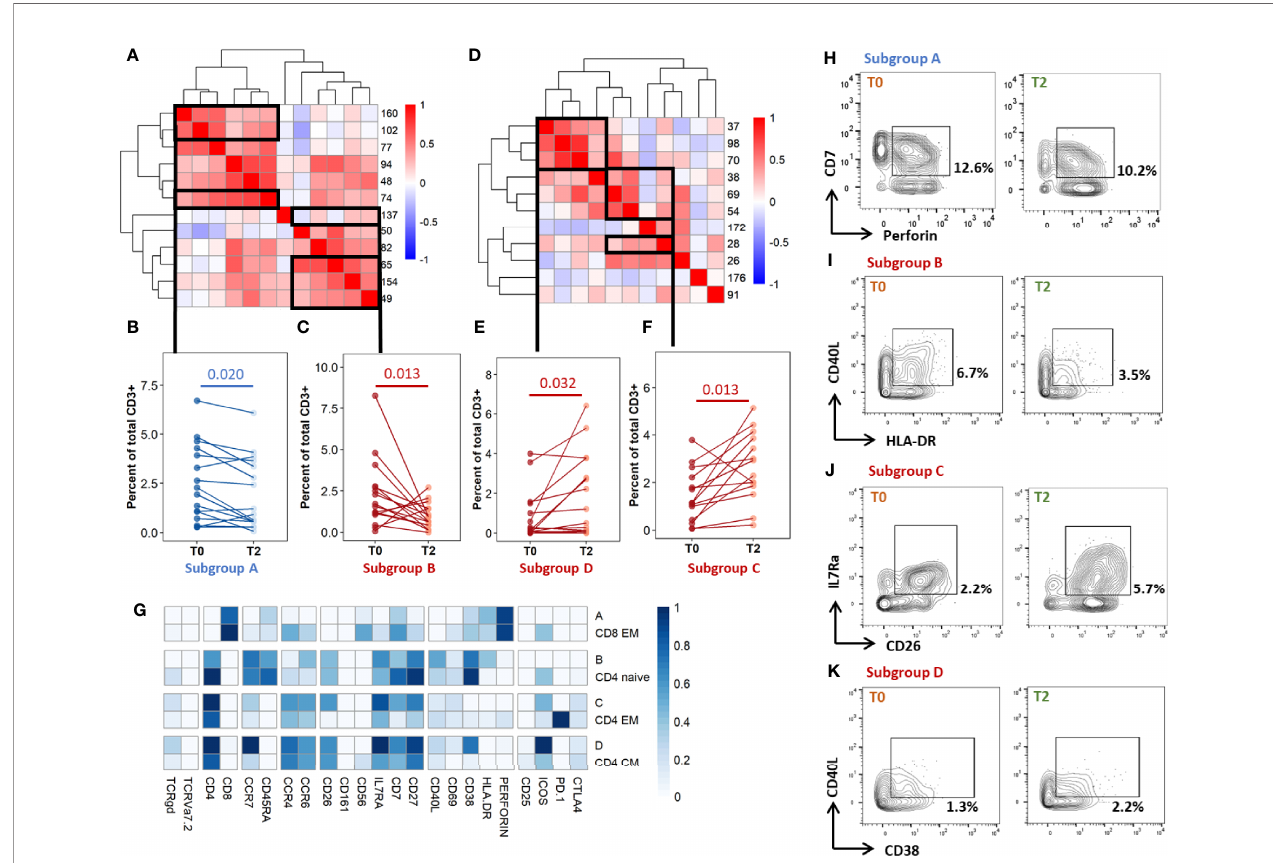
FIGURE 5 | Individual immunopro fi ling con fi rms differential abundance of correlated subsets in cured patients after treatment. Cluster were strati fi ed by type of signi fi cant abundance change: enrichment (A-C) or depletion (D-F) after treatment completion. (A, D) Pearson ’ s correlations were calculated on cluster abundance at T0 and displayed on a heatmap with hierarchical clustering. Clusters with similar immunophenotypes ( Figures 3 , 4 ) and positive correlation coef fi cients were grouped. Estimates of effect sizes are in Supplementary Tables 6, 7 . (B, C, E, F) The abundance of each subgroup was visualized. Each dot represents data for one patient. Statistical analysis: Friedman rank sum test. Subgroup A: data from rmsHBHA samples (n =14), clusters 74, 102, 160; p = 0.020, Fchisq = 5.4. Subgroup B: data from unstimulated samples (n =16), clusters 137, 154, 65, 82; p = 0.0013, Fchisq =10.3. Subgroup C: data from unstimulated samples, clusters 38, 54, 69, 28; p = = 0.0013, Fchisq = 10.2. Subgroup D: data from rmsHBHA samples, clusters 37, 70, 98; p = 0.032, Fchisq = 4.57. (F) For each subgroup, normalized mean marker expression levels were compared with similar T-cell subsets. (G – K) Manual gating analysis was performed to verify unsupervised results (representative plots, 500 to 1,000 events). Numbers indicate the percentage of gated cells among total CD3 + cells. Subgroup A: CD3 + CD8 + CCR7 - CD45RA - CD7 + Perforin + . Subgroup B: CD3 + CD4 + CCR7 + CD45RA - CCR6 + IL7Ra + CD27 + CD40L + CD38 + HLA-DR + . Subgroup